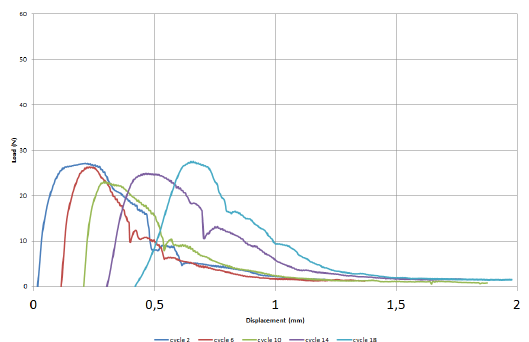
Figure 8: Load vs displacements plot of the extraction test carried out without gel